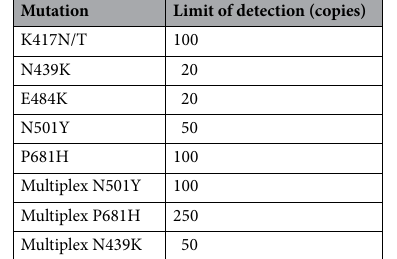
Table 2. Limit of detection 95% of the